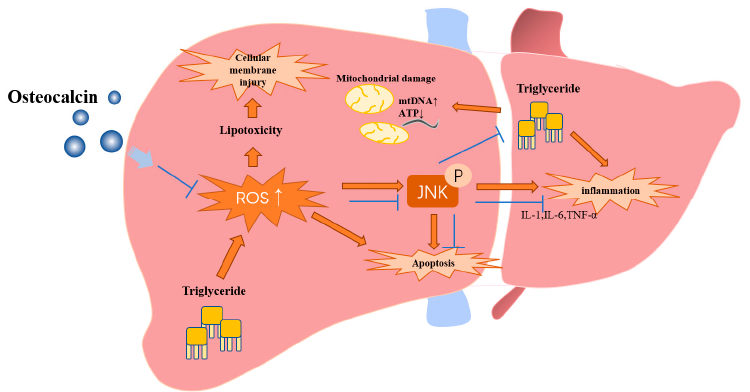
Figure 2. The diagram depicting the regulation of OCN effects on FLHS via the JNK signaling pathway [25]. ucOCN exerts its protective function through the ROS–JNK signaling pathway. In the liver, excess triglycerides lead to increased ROS synthesis, consequently increasing cellular membrane injury, hepatocyte apoptosis, and inflammatory reaction and upregulating the JNK signaling pathway. OCN functionally alleviates hepatocyte injury and associated mitochondrial damage, ROS synthesis, and inflammatory cytokine production by inhibiting the JNK signaling pathway.